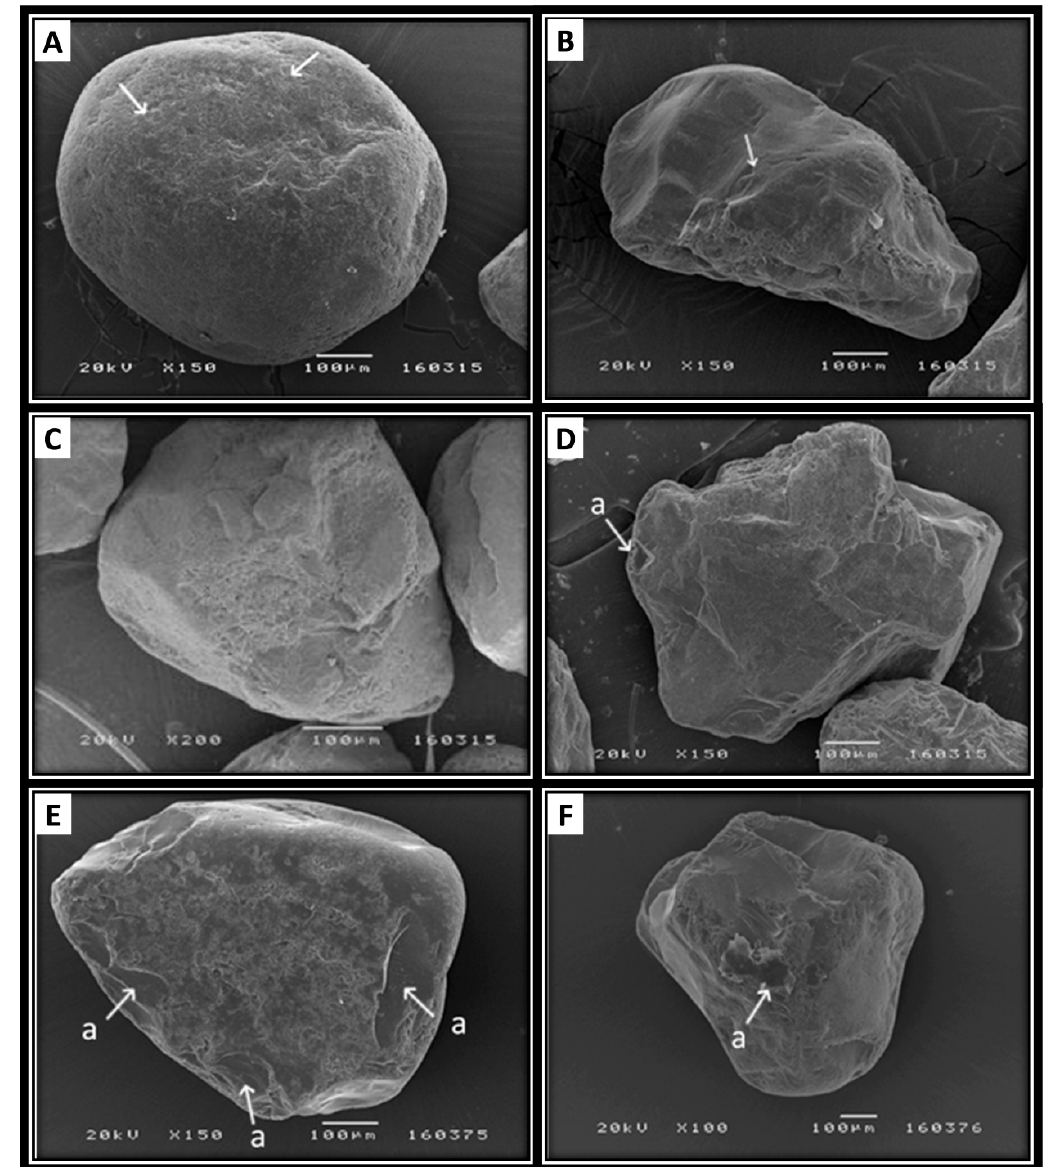
Figure 5. Micrographs of quartz grains from UL3 unit—( A , B )—UL3a subunit: ( A )—Well-rounded with low relief grain and small percussion marks features from the base of deposit; ( B )—Subangular grain with rounded edges and “V” shapes and washed appearance; ( C , D )—UL3b subunit: ( C )—Subrounded grain with dissolution features marks and low relief; ( D )—Angular grain with large “V” shape and medium relief; ( E , F )—UL3c subunit: ( E )—Rounded, shiny and looking washed grain, with low relief and percussion marks (a-conchoidal fractures); ( F )—subrounded grain with medium relief, with several fresh surfaces. (a) indicates silica flowers.